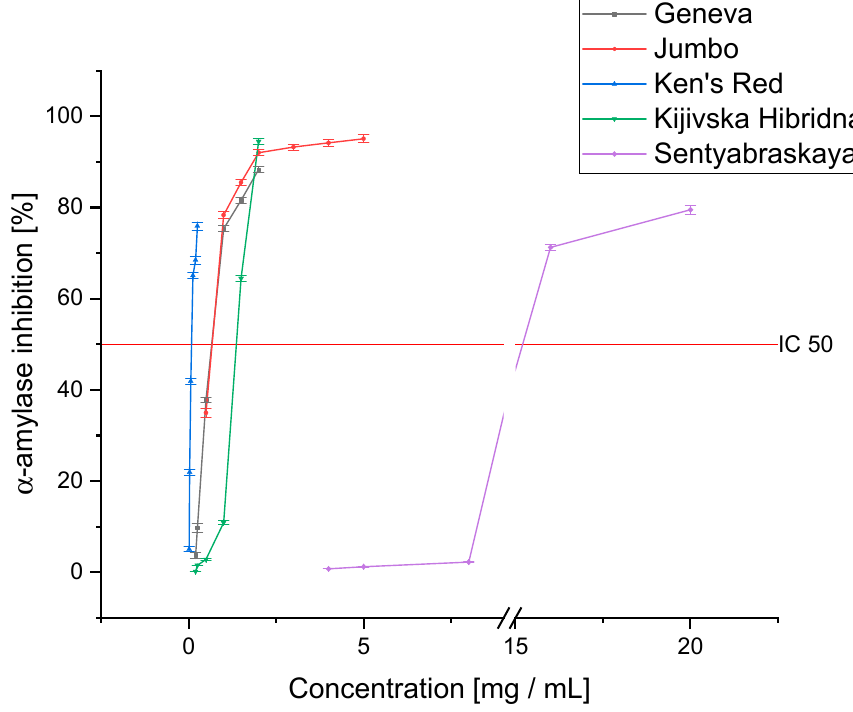
Figure 4. The ability of the tested cultivars to inhibit α -amylase.